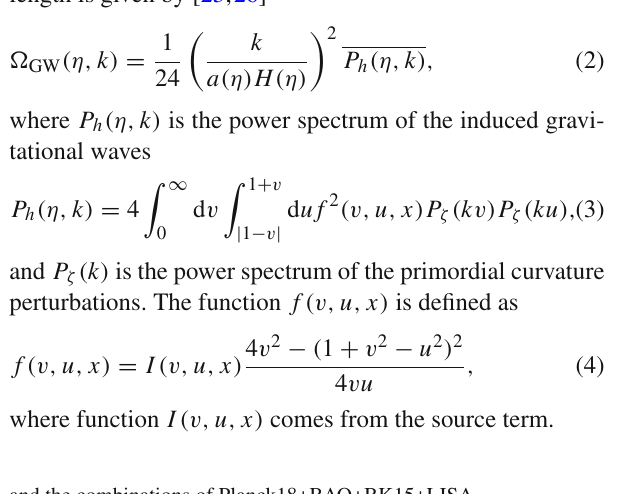
Table 1 The 68% limits on the cosmological parameters in the (cid:2) CDM+ r model from the combinations of Planck18+BAO+BK15